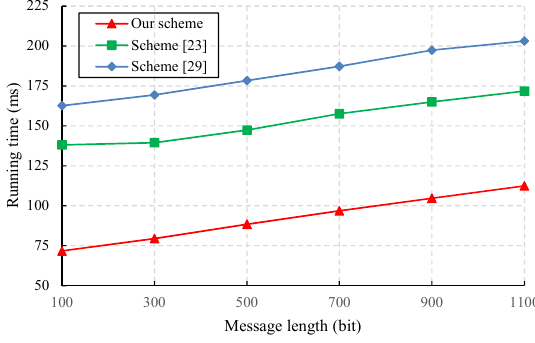
Figure 6. A comparison of the signature verification